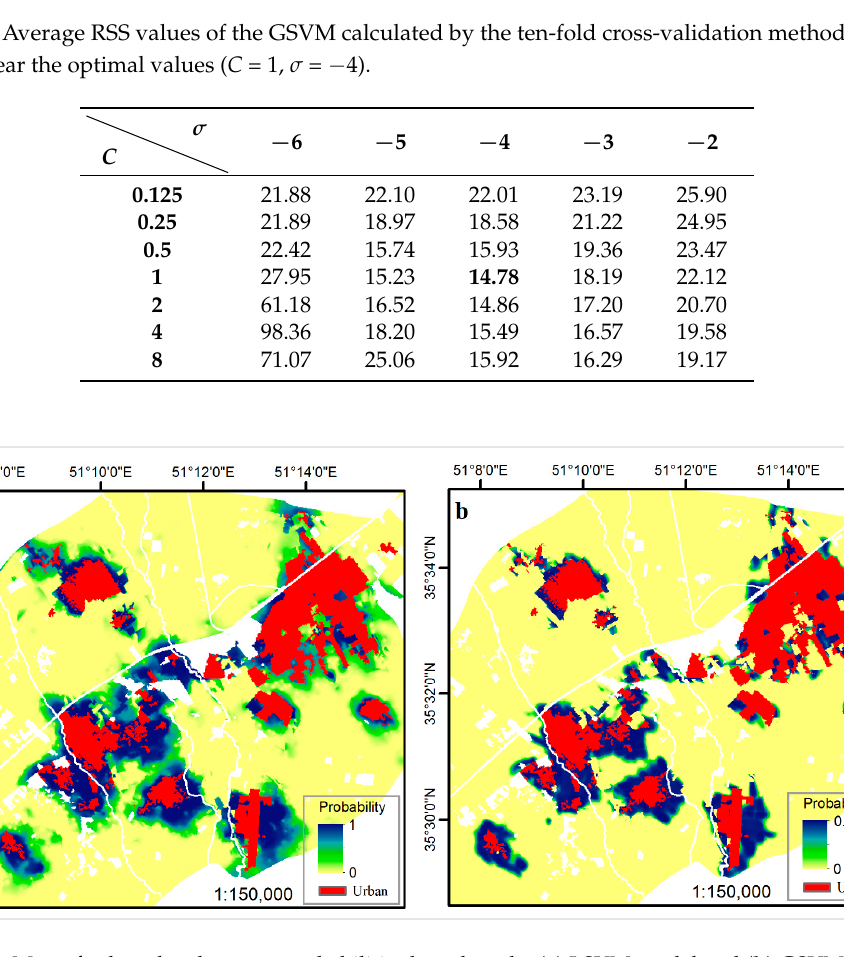
Figure 8. Map of urban development probabilities based on the ( a ) LSVM model and ( b ) GSVM model.